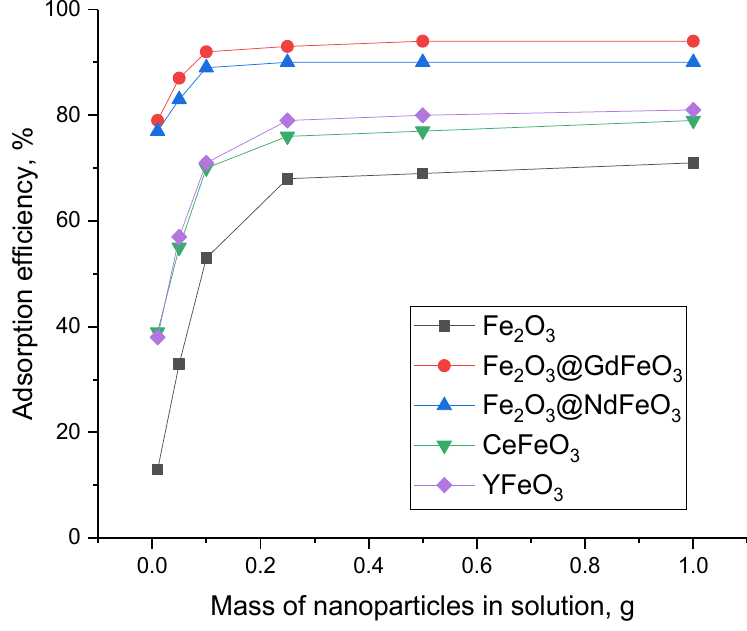
Figure 6. Results of changes in the manganese adsorption efficiency with variation in the mass of